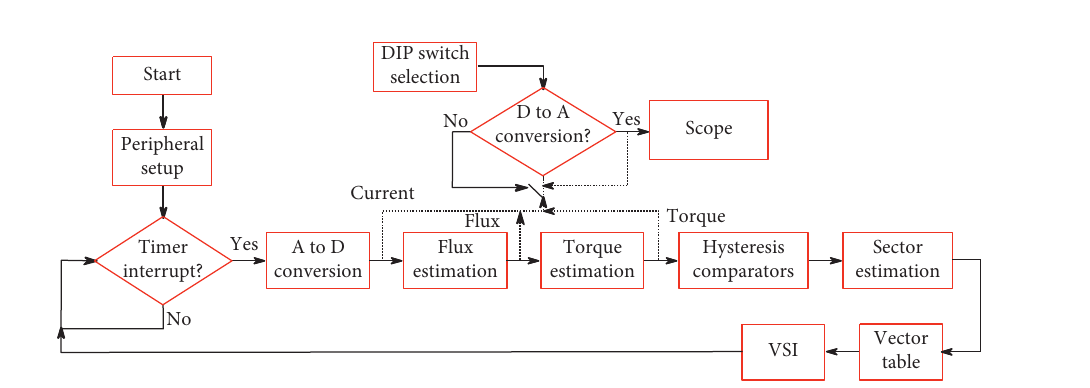
Figure 8: DTC algorithm